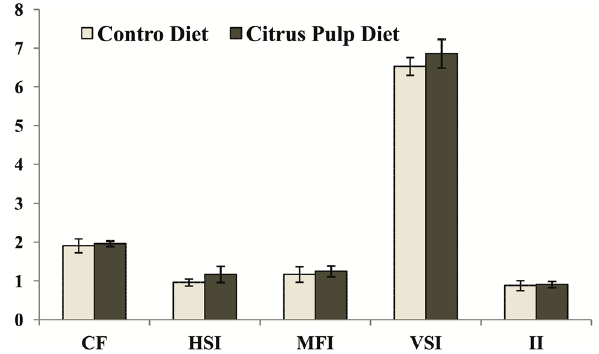
Fig. 1 Biometric values on sharpsnout sea bream at the end of the trial fed with citrus pulp diet and control diet. Values are ± SD of three replications. Data in the same row with different superscripts differ at P < 0.05. Condition factor (CF) = [body weight (g)/fork length (cm) 3 ] × 100. Viserosomatic index (VSI) = 100 × [visceral weight (g)/fish weight (g)]. Mesenteric fat index (MF) = [mesen- teric fat weight (g)/body weight (g)] × 100. Hepatosomatic index (HSI) = [liver weight (g)/body weight (g)] × 100. Gonadosomatic index (GSI) = 100 × [gonads weight (g)/fish weight (g)]